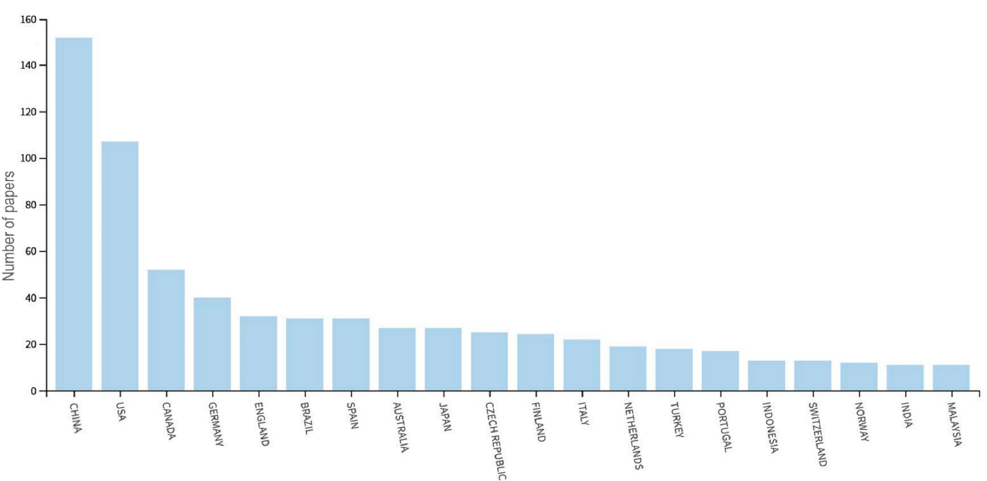
Figure 4. Bar graph of the top 20 authors’ countries for the first-step filtering records.